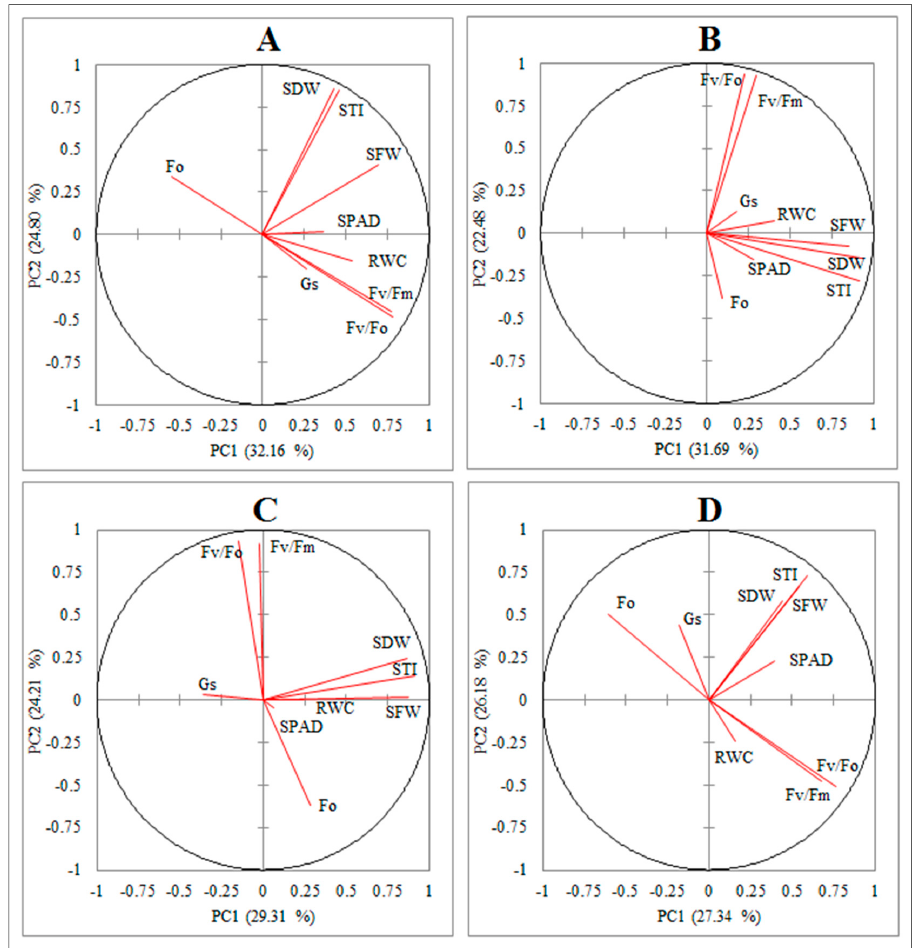
Figure 5. Biplots based on the different physio-chemical traits, shoot biomasses and STI index in: ( A ) T. aestivum , ( B ) Ae. tauschii , ( C ) Ae. cylindrica and ( D ) Ae. crassa species. SPAD, Gs , Fo , Fv / Fo , Fv / Fm , SFW, SDW and STI indicate the relative chlorophyll content, stomatal conductance, initial